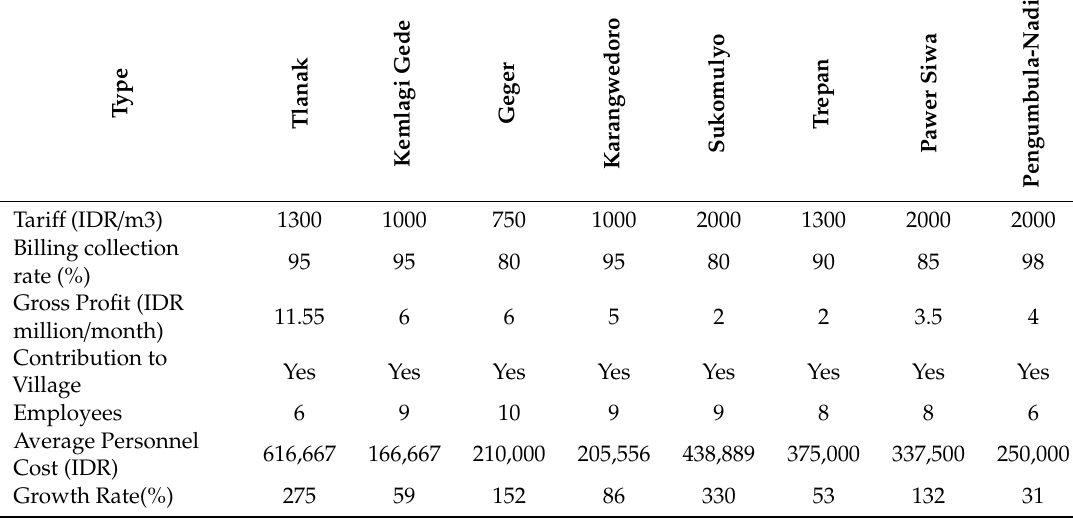
Table 2. Overview of HIPPAMs